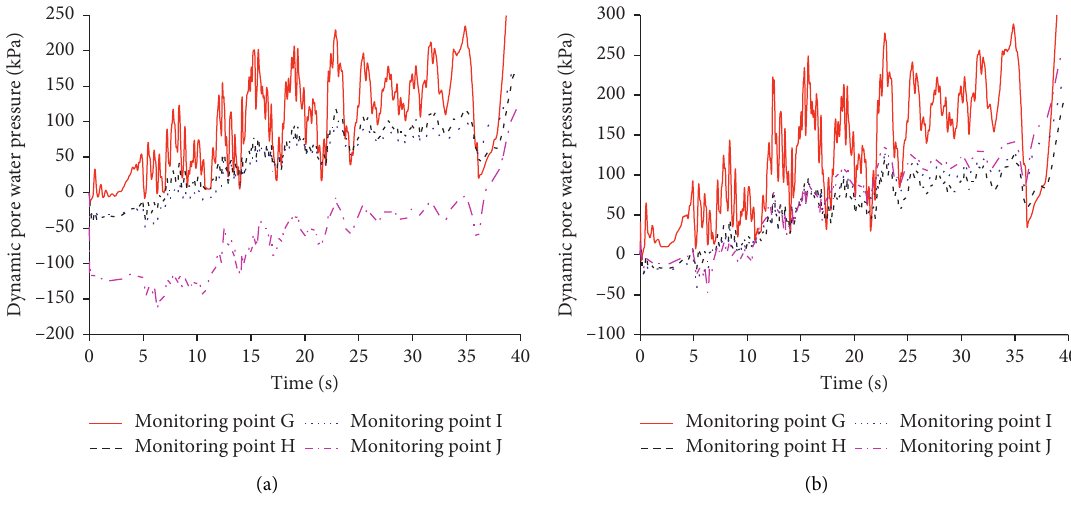
Figure 13: The dynamic pore water pressure under T1-II-1. (a) 14m. (b) 20m.